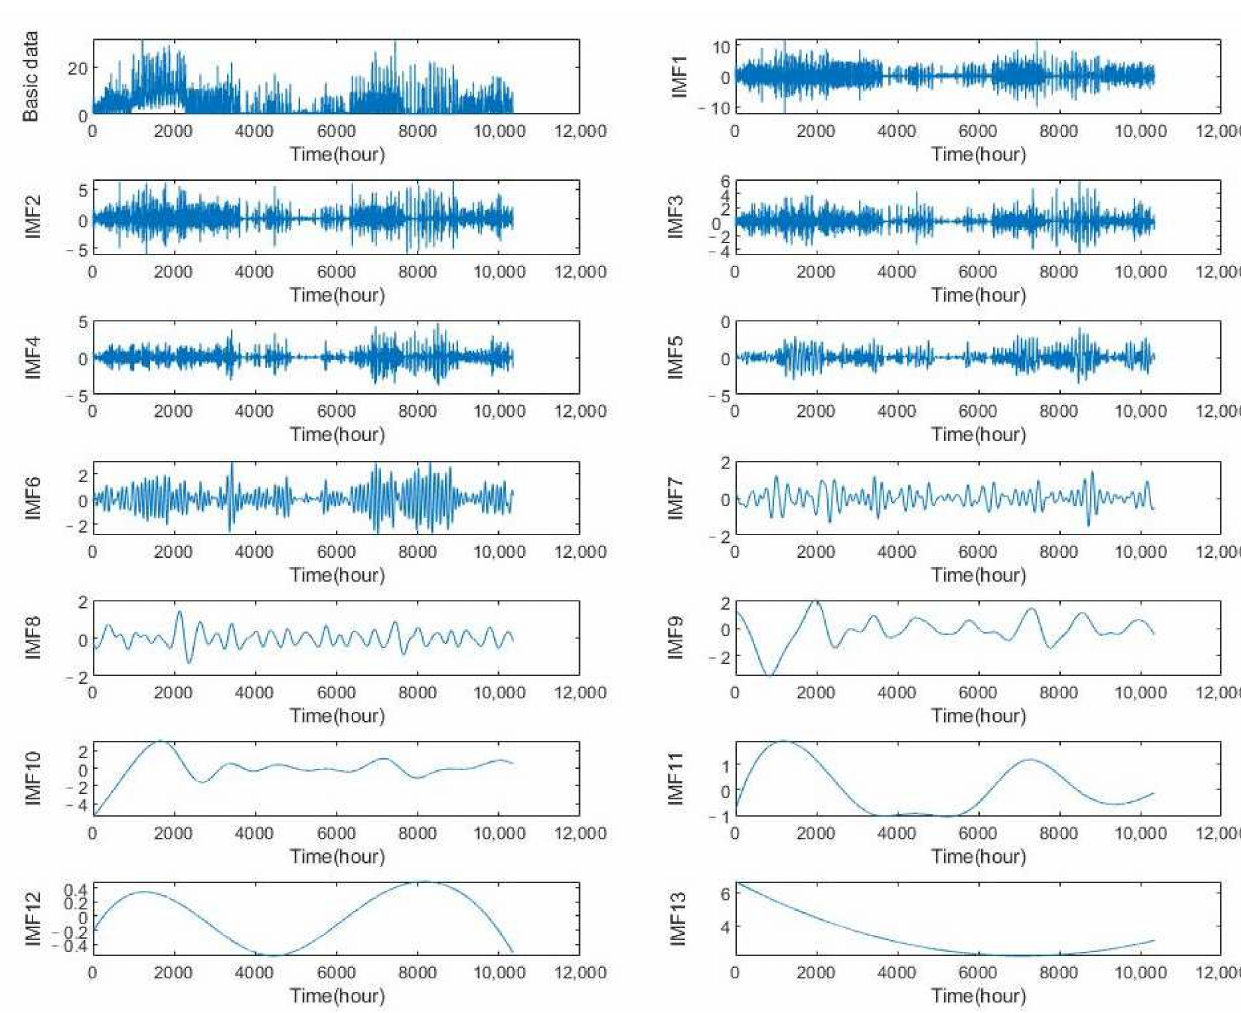
Figure 4. Ensemble empirical mode decomposition of reactive